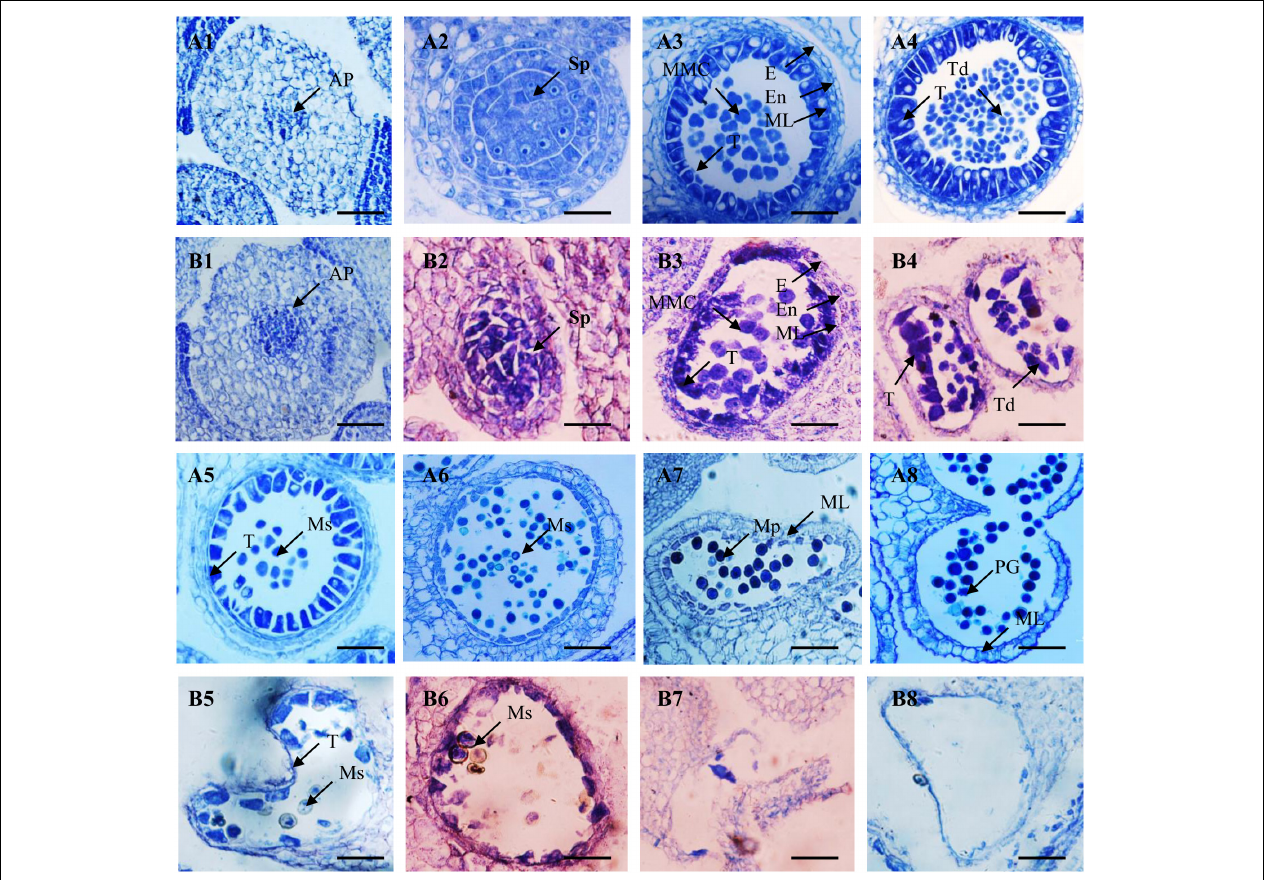
FIGURE 2 | Microstructure of fertile (A1–A8) and sterile (B1–B8) anthers from F 2 plants. (A1,B1) Anther primordium stage; (A2,B2) sporoblast stage; (A3,B3) microspore mother cell stage; (A4,B4) tetrad stage; (A5,B5) early mononuclear stage; (A6,B6) mononuclear stage; (A7,B7) dinuclear stage; (A8) mature microspores; and (B8) empty pollen sac. AP, anther primordium; Sp., sporogenous cell; E, epidermis; En, endothecium; ML, middle layer; T, tapetum; MMC, microspore mother cells; Ms, microspore; MP, mature pollen; PG, pollen grain. Bars = 100 µ